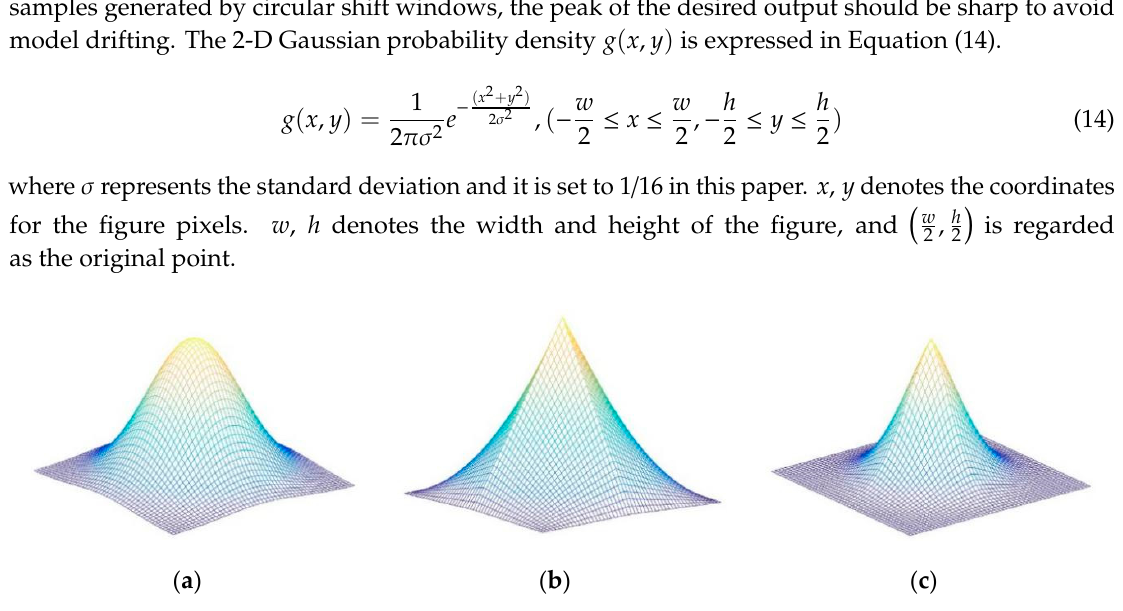
Figure 4. Different distributions of the desired correlation output: ( a ) 2-D Gaussian distribution; ( b ) 2-D triangle distribution; ( c ) 2-D merged distribution.